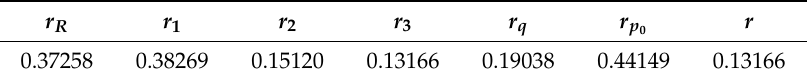
Table 3. Different values of parameters which satisfy Theorem 1.